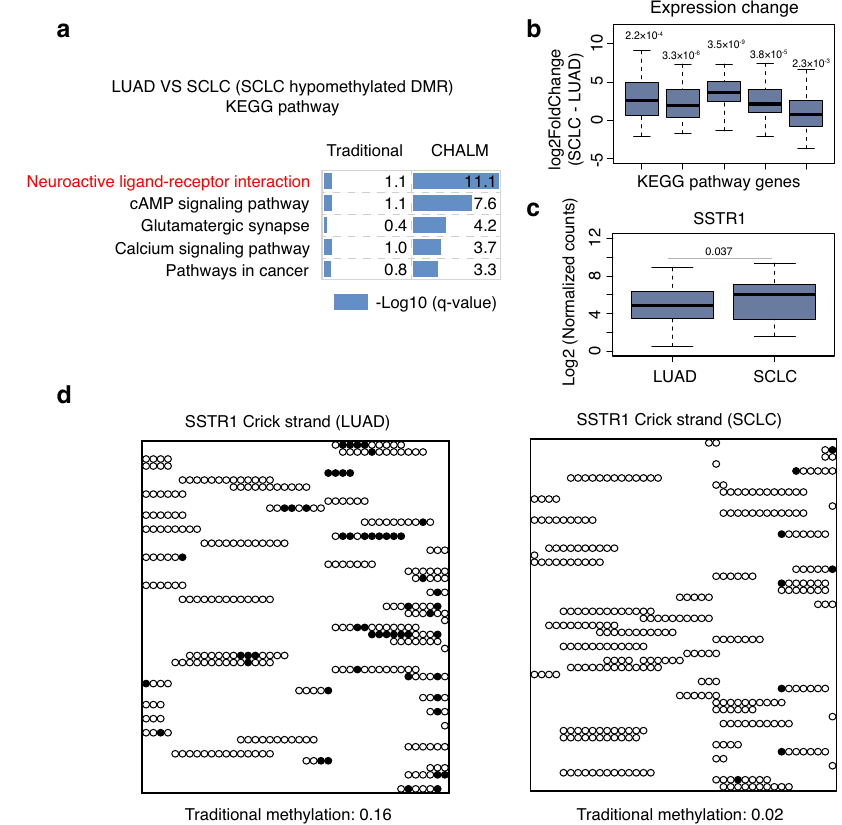
Traditional methylation: 0.16 Traditional methylation: 0.02 CHALM methylation: 0.55 CHALM methylation: 0.14 Fig. 5 CHALM provides better identi fi cation of functionally related DMRs. a KEGG pathway enrichment of the top 2000 hypomethylated DMRs in SCLC. ‘ q -value ’ refers to one-sided Fisher ’ s Exact test P value adjusted by Benjamini – Hochberg procedure. b Expression change of genes with hypomethylated DMRs in the KEGG pathways shown in a between LUAD (79) and SCLC (79) patients. The left-to-right order is the same as the top-to-right order shown in a . Two-sided one-sample t -test is used. Sample sizes from left to right for test are 57, 41,24, 30, and 49, respectively. c Expression of SSTR1 in LUAD (79) and SCLC (79) patients. Two-sided Wald test P value is adjusted by Benjamini – Hochberg procedure. d Methylation status of reads mapped to the CHALM- unique hypomethylated DMR found in the SSTR1 promoter region. Only 50 reads are selected for visualization. The methylation levels shown were calculated based on the original dataset. Black circles: mCpG; white circles: CpG. Boxplot de fi nition: line in the box center refers to the median, the limits of box refer to the 25th and 75th percentiles and whiskers are plotted at the highest and lowest points within the 1.5 times interquartile